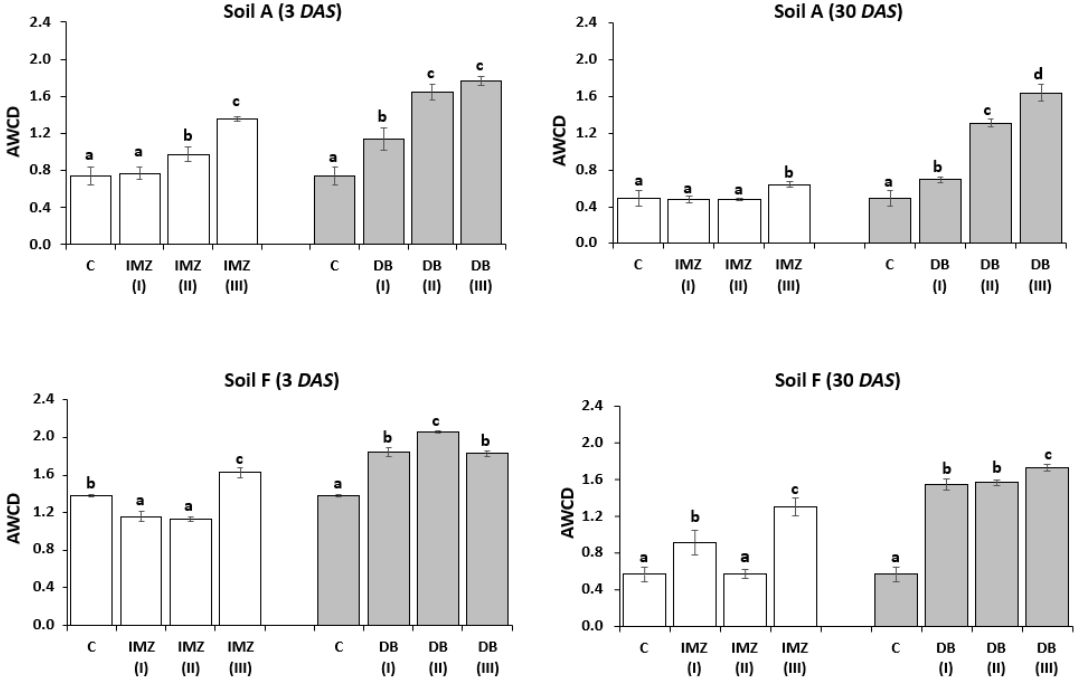
Figure 4. Influence of different concentrations of imazamox (IMZ) and 2,4-DB (DB) on Biolog average well color development (AWCD; mean values ± SE) at 3 and 30 days after herbicide spiking ( DAS ). IMZ(I), (II) and (III) refer to 3, 15, 150 µg IMZ g − 1 soil, respectively. DB(I), (II) and (III) refer to 100, 500, 5000 µg DB g − 1 soil, respectively. C, control (untreated) soil. For each soil and herbicide, different letters on top of bars indicate statistically significant differences (Bonferroni corrected p -value < 0.05).